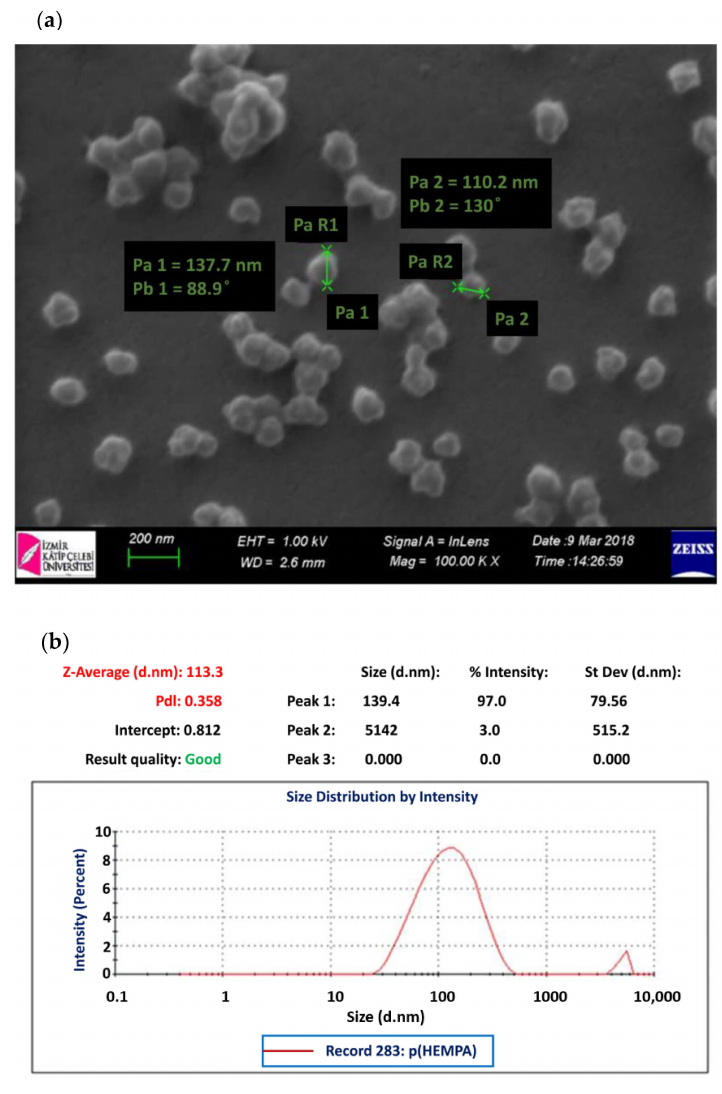
Figure 3. HEMPA nanopolymer synthesized using the mini-emulsion polymerization technique: ( a ) SEM micrographs; ( b ) zeta sizer analysis.